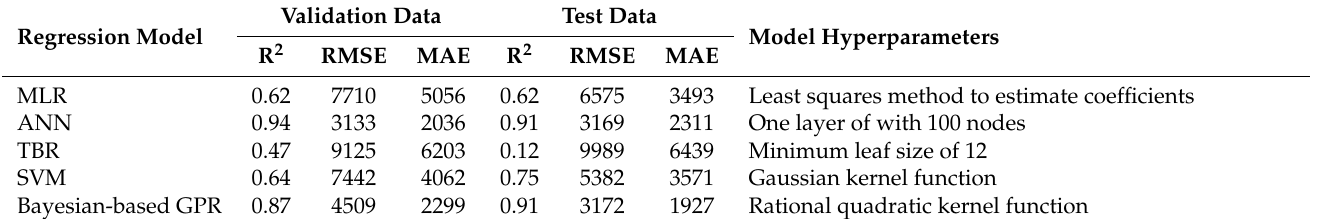
Table 5. Performance of prediction models across occupations groups.